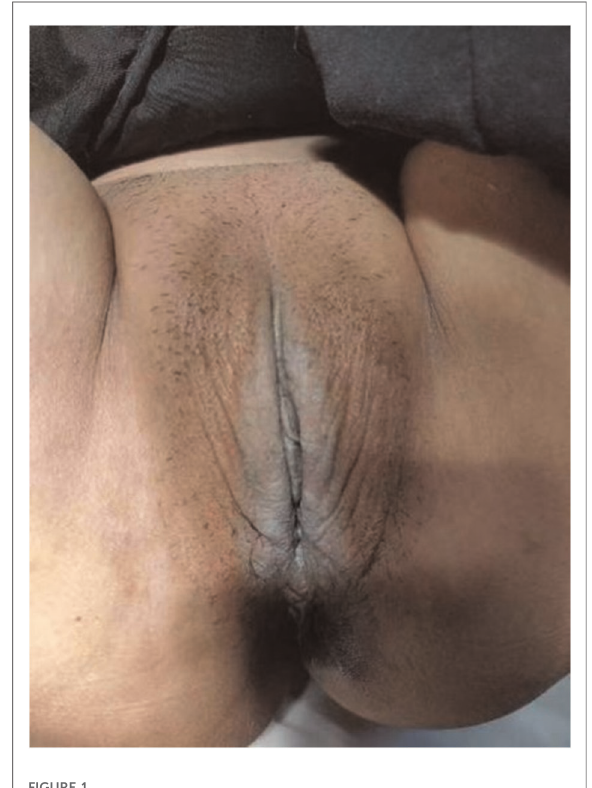
FIGURE 1 The genital area before MF laser